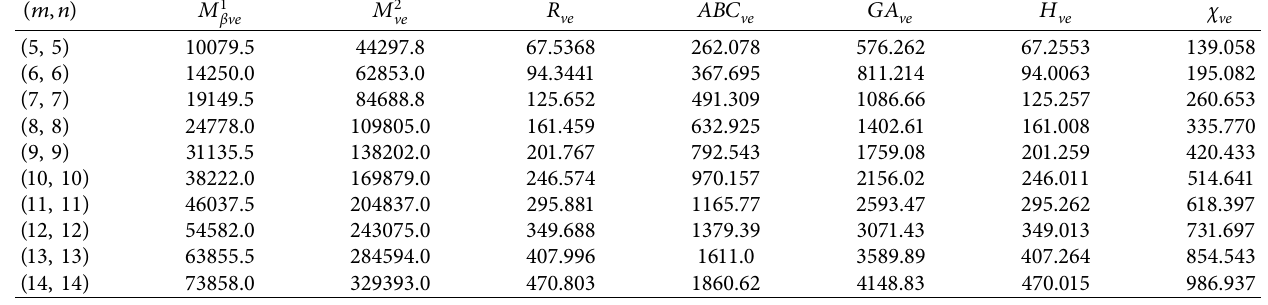
Table 4: The ve -degrees of each edge of Y 3